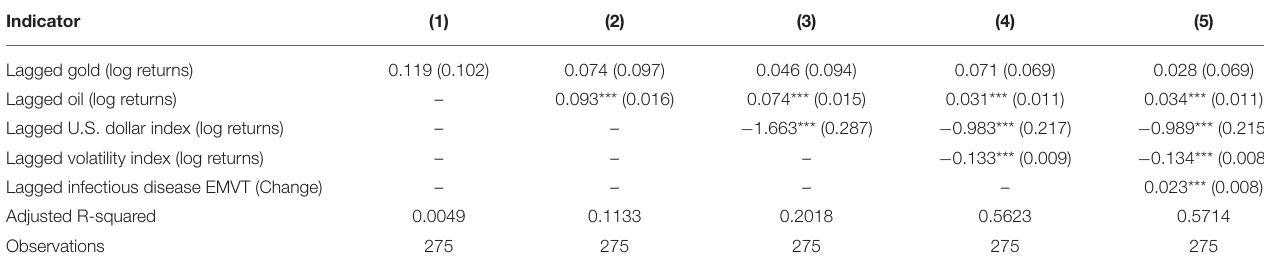
TABLE 5 | Results of the LARS estimations (lagged model).